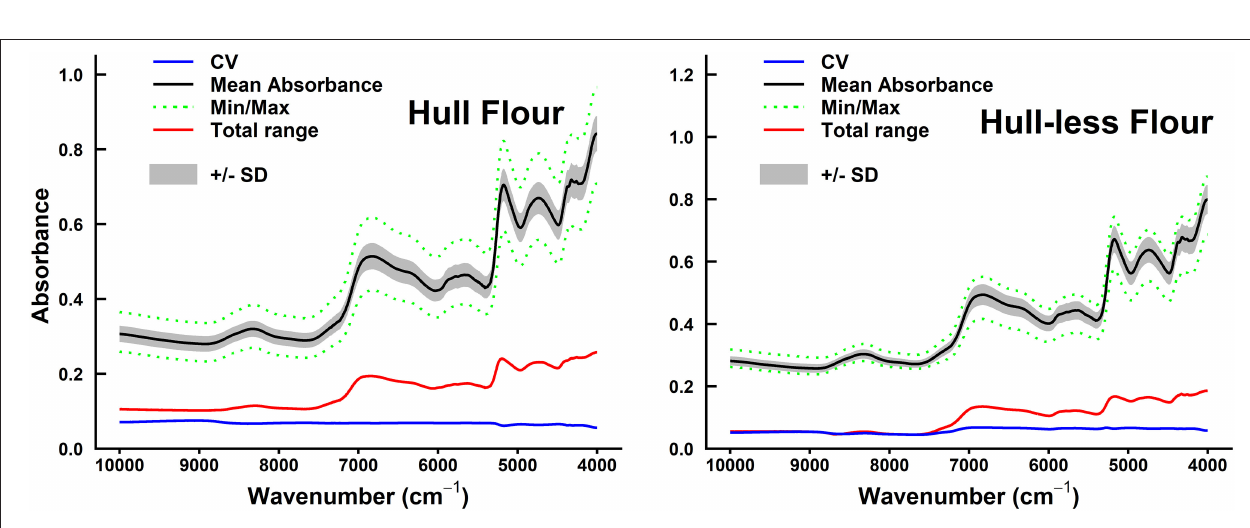
FIGURE 3 | Summary of spectral absorbance and characteristic wavelengths distribution measurements for sorghum hulled ( n = 61) vs. hull-less grain flours sample set ( n = 37). The CV, coefficient of variation (blue line) (SD/mean), mean absorbance (black line), minimum/maximum (green dotted line) spectral absorbance, total range of absorbance measurements (red line) for each wavelength (cm − 1 ), and + /– SD between sample sets were